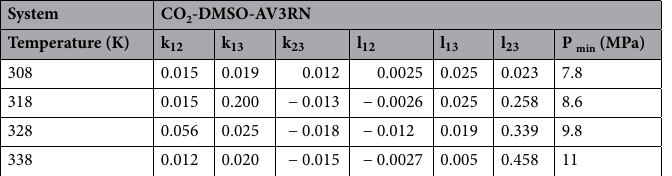
Table 4. Binary interaction parameters from PR-EoS with the vdW2 mixing rule for the ternary system (CO 2 (1)—DMSO (2)—AV3RN (3)).